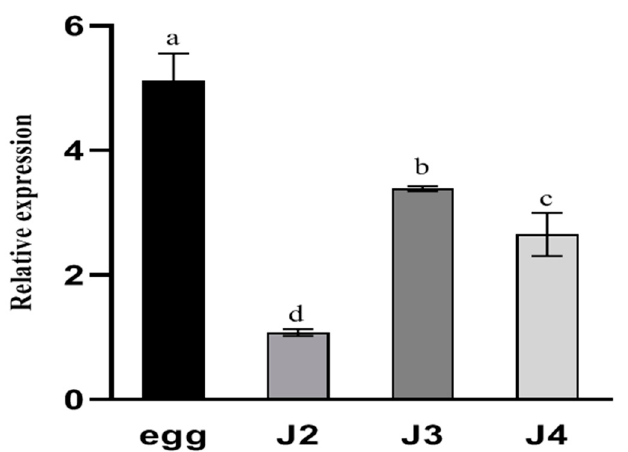
Figure 5. Relative transcript abundance of the DdCa v α 2 δ gene at each developmental stage. Using the transcript levels in J2 as a reference, DdCa v α 2 δ was significantly upregulated in other stages (J2, J3, and J4). Quantitative RT-PCR values are the mean ± standard error. Letters indicate significant differences according to Duncan’s one-way ANOVA of SPSS 21.0 Software ( p < 0.05). Tissue